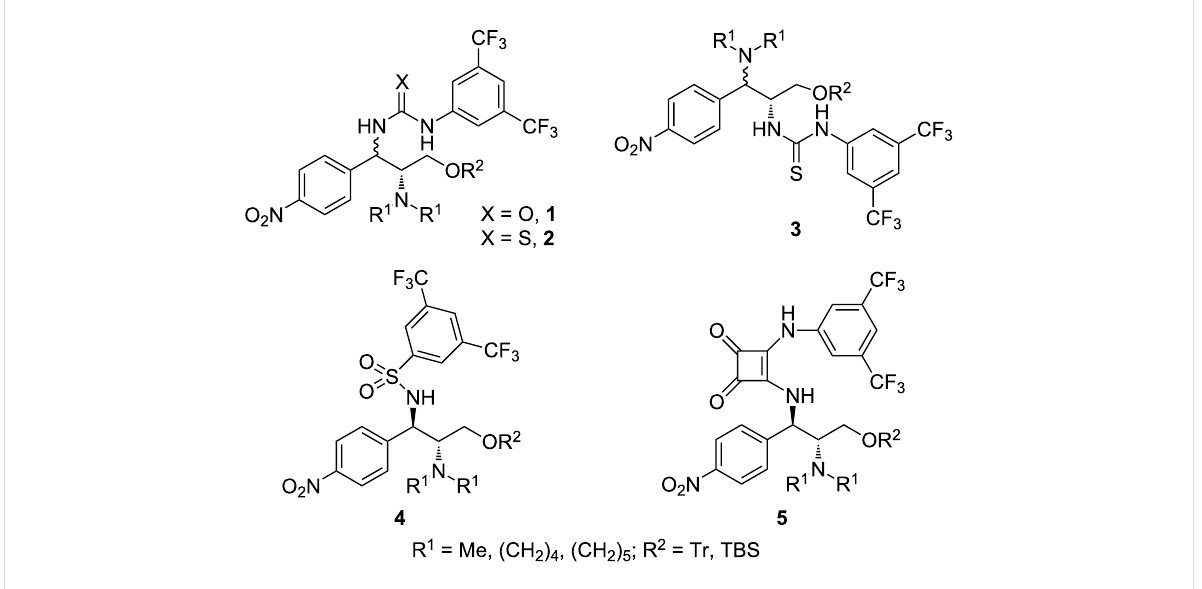
Figure 1: Chloramphenicol-base-derived bifunctional organocatalysts.